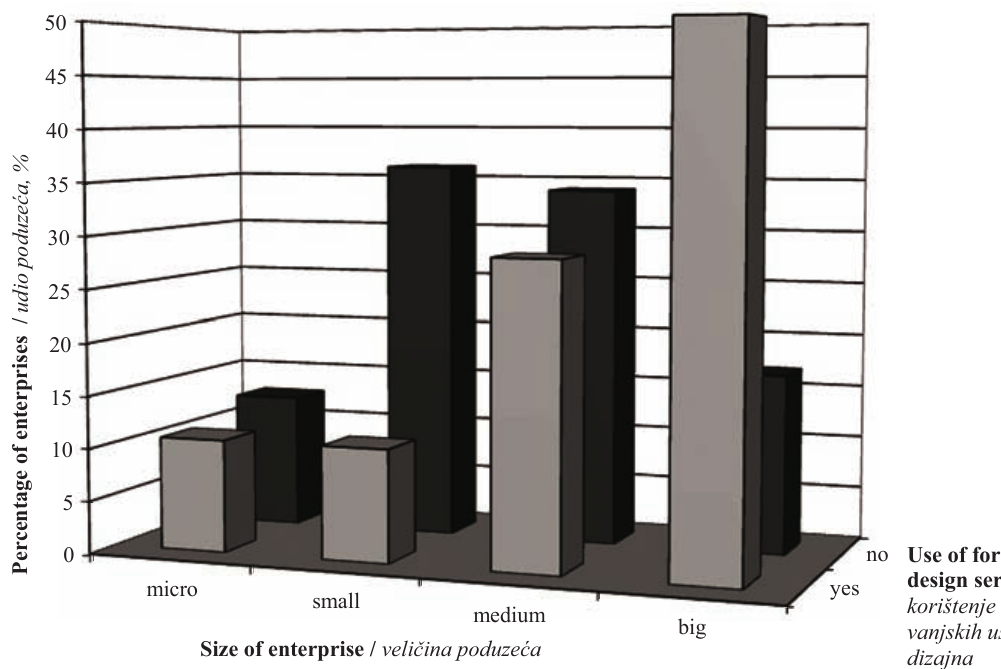
Figure 2 Structure of analysed furniture manufacturers in terms of the enterprise size and their use of services offered by foreign design agencies or